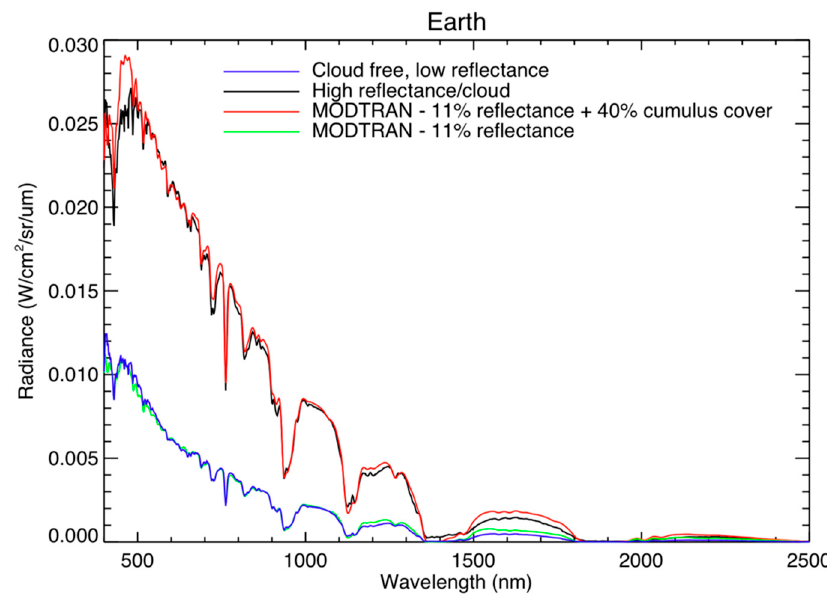
Figure 2. Calibrated OVIRS Earth spectra acquired near the OSIRIS-REx closest approach. The blue line represents a cloud-free view over the ocean, and the black line is a nearby footprint that contained cloud cover. Model atmospheres from MODTRAN (green and red lines) are shown for comparison.